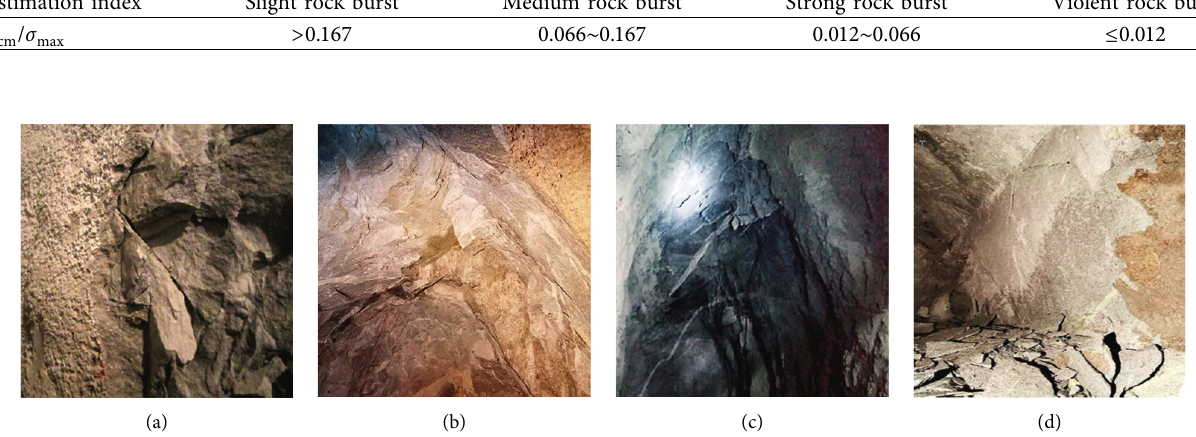
Table 8: Rock burst estimation criterion based on the ratio of σ